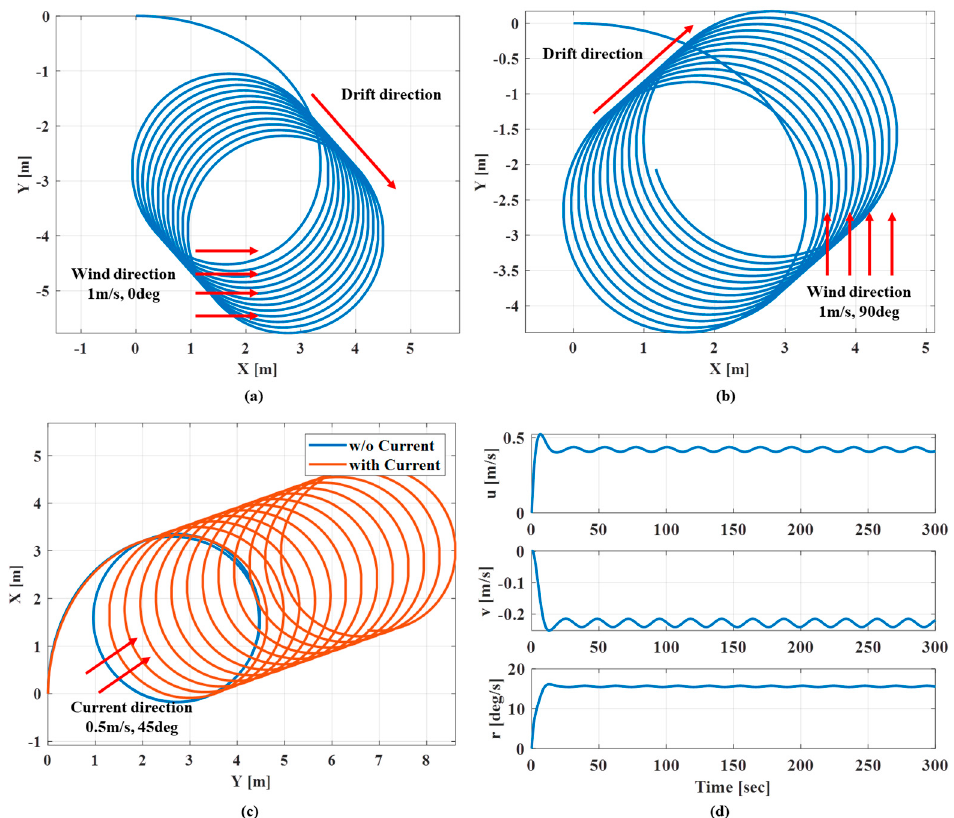
Figure 14. Simulation results of dynamic behavior of USV with disturbance: ( a ) Turning motion of the USV with wind load (1 m / s, 0 deg); ( b ) With wind load (1 m / s, 90 deg); ( c ) With current (0.5 m / s, 45 deg); ( d ) Linear and angular velocity of the USV with current (0.5 m / s, 45 deg).